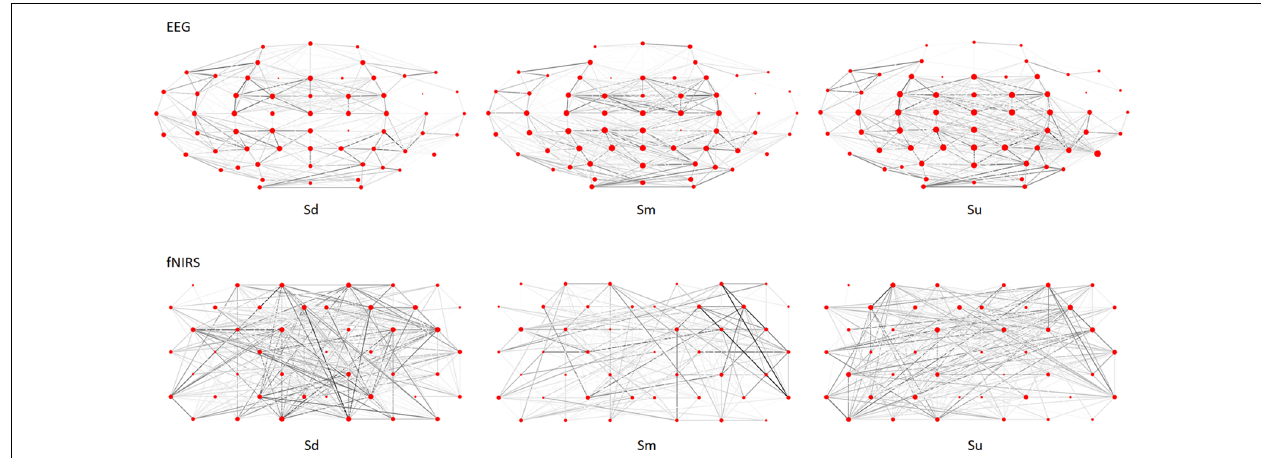
FIGURE 11 | Complex brain networks of EEG and fNIRS datasets for participant No.